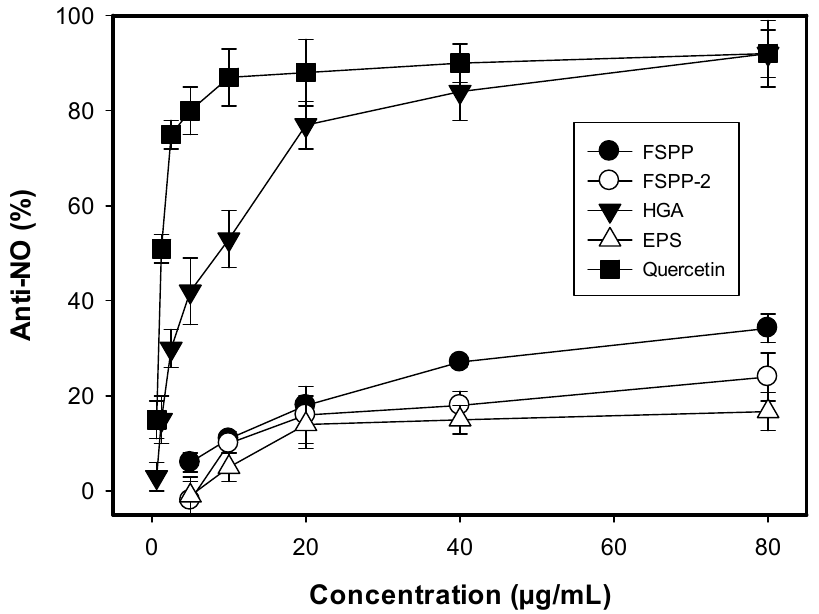
Figure 5. Anti-inflammation activity of FSPP, FSSP-2, and its isolated compounds. The cells of murine RAW 264.7 monocyte/macrophage were used as cell line model for testing anti-NO activity at the concentration range of 5–80 µg/mL of the samples and 0.625–80 µg/mL of positive control (quercetin).